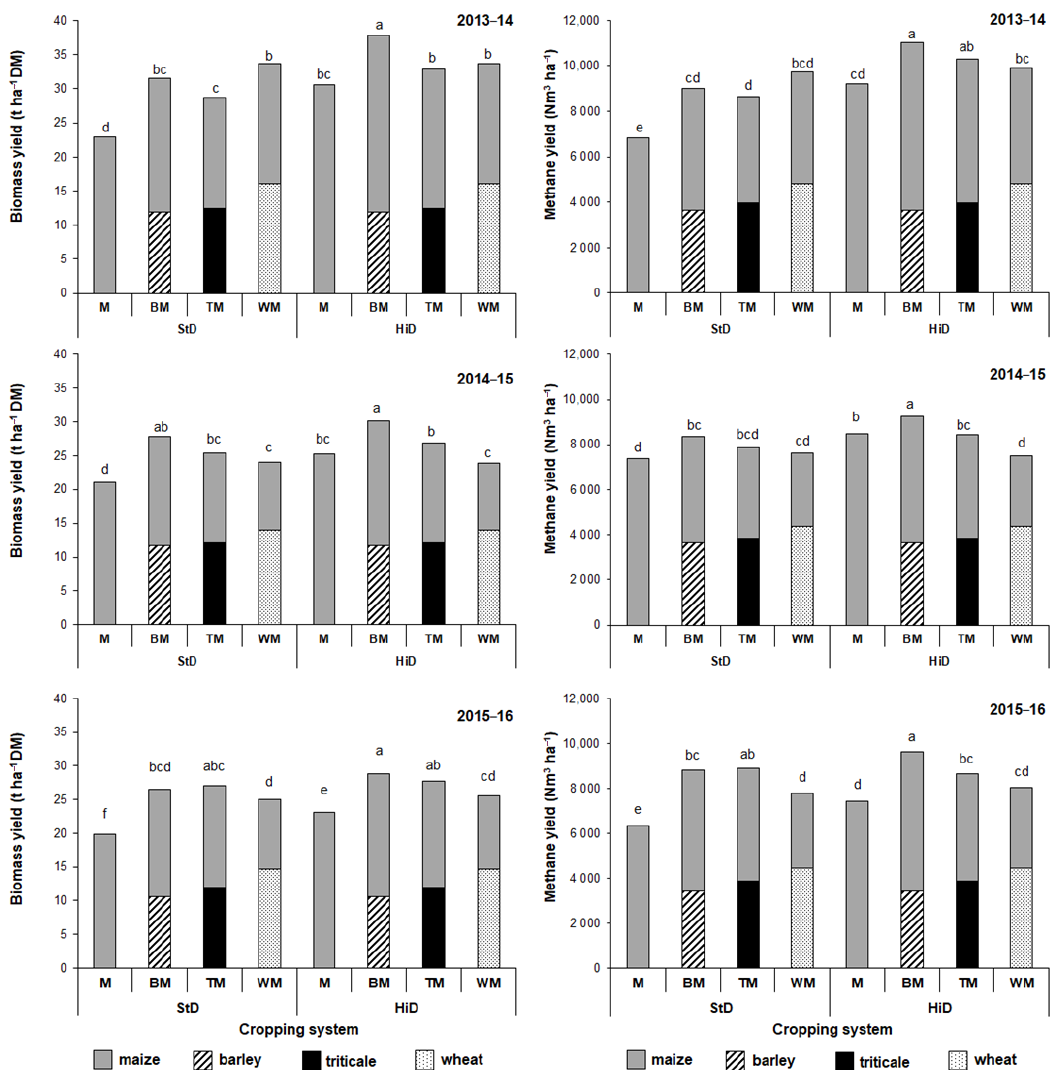
Figure 1. Effect of the cropping systems according to the different winter cereal-maize combinations and maize plant densities on the biomass and methane yields per hectare. M, single maize crop planted in spring; BM, double crop with hybrid barley followed by maize; TM, double crop with triticale followed by maize; WM, double crop with common wheat followed by maize. Maize plant densities: StD, a standard planting density (7.5 plants per m − 2 ) with plants sown at a wide inter-row spacing of 0.75 m; HiD, a high planting density (10 plants per m − 2 ) with plants sown at a narrow inter-row spacing of 0.5 m. Different letters on the bars indicate significant differences ( p < 0.01), according to the REGW-Q test. As far as the maize cultivated as a single crop is concerned, HiD always led to a sig- nificant increase in the biomass (+23%) and methane yields (+22%), compared to StD. The cropping system with HiD sole-crop maize resulted in a similar biomass and methane yield to that of the triticale – StD maize and the wheat – StD maize systems in the 2013 – 14 and 2014 – 15 growing seasons. Moreover, the application of a high plant density cultiva- tion of maize did not lead to any significant increase in the methane yield, compared to the standard density in the triticale + maize and wheat + maize double cropping systems.